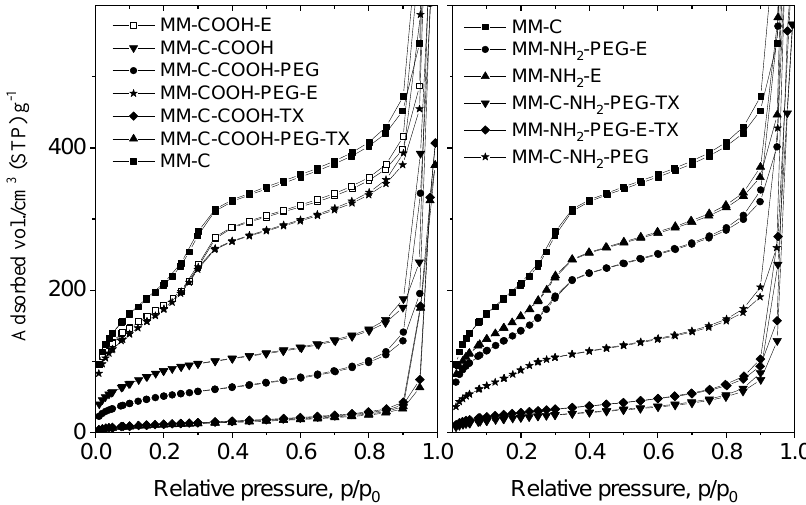
Figure 3. N 2 physisorption isotherms of the MM sample and tamoxifen-loaded formulations.